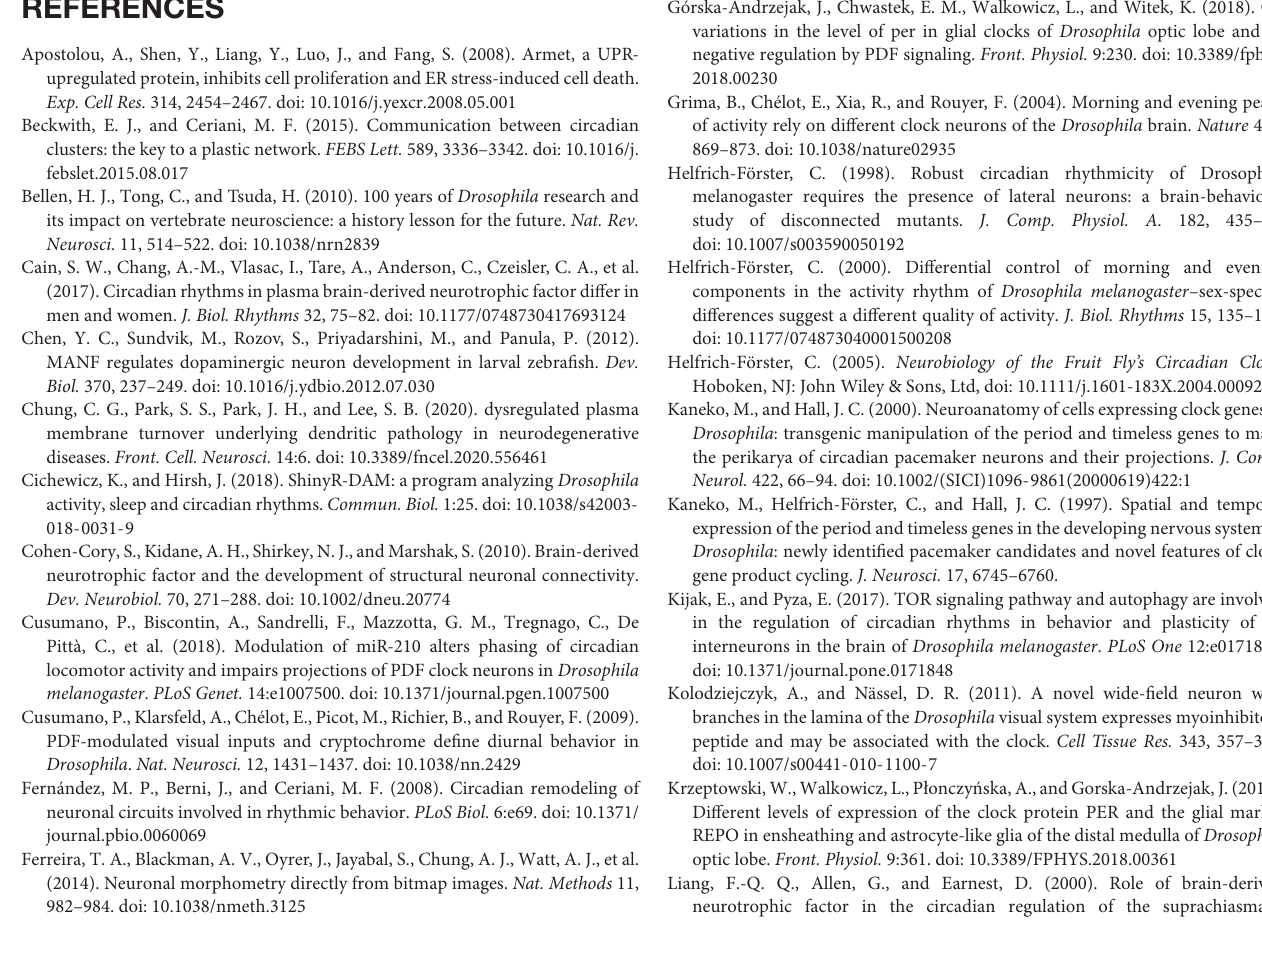
Supplementary Figure 6 | Sholl analysis of s-LNv projections of tim > DmMANF-RNAi Dcr2 flies. Sholl analysis shows no differences